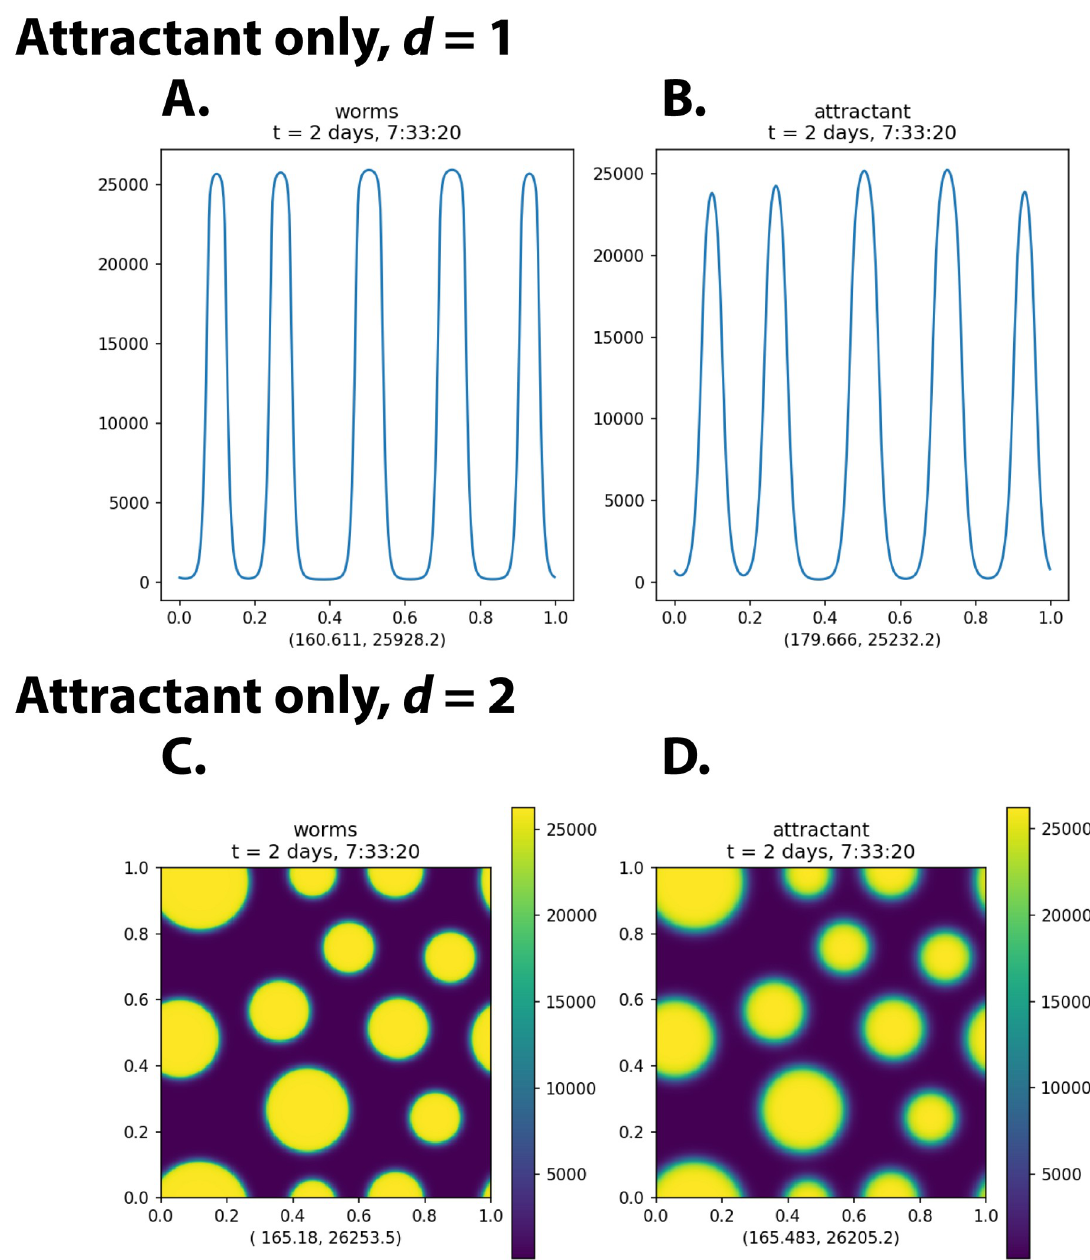
Fig 2. Simulation of the attractant-only model. This figure shows the state of a numerical simulation of the attractant-only model after 20 0000 s (2 days and 7 hours). The initial condition was a uniform worm density of � r ¼ 9000 cm (cid:0) d , perturbed by normally distributed random noise of standard deviation 1% (i.e. 90 cm − d ). (The entire time courses can be seen in S2 and S3 Videos in the Supporting Information.) S1 Fig shows results at t = 200 000 s and t = 1 × 10 7 s (116 days) of ten independent runs of the same simulation with different pseudorandom noise in the initial condition. Panels A, B show the results of simulations in one-dimensional space; C, D show results in two-dimensional space. A, C show density ρ ; B, D show attractant concentration U . The two numbers below each plot are the minimum and maximum values of the plotted function over the entire 1 cm × 1 cm domain. The spatial units are centimeters.